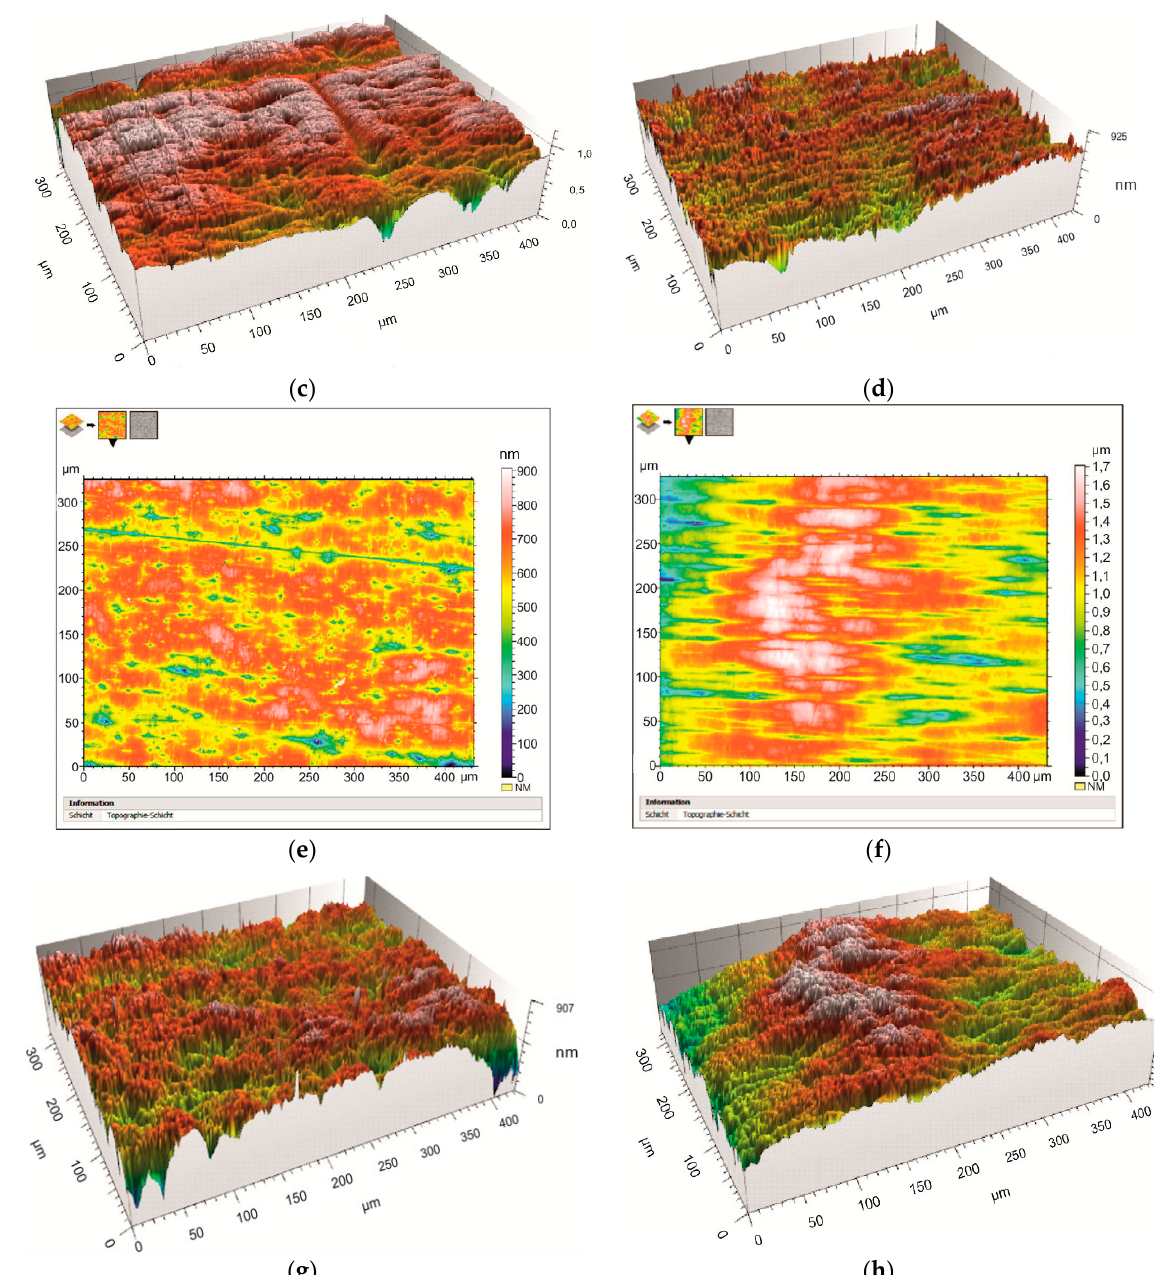
Figure 5. Topography of flat surfaces of specimens from alloys VT23 ( a , c ) and VT23M ( e , g ) in the initial state ( a , c , e , g ) and after DNP ( b , d , f , h ): a , b , e , f —2D-measurements; c , d , g , h —3D-measurements.